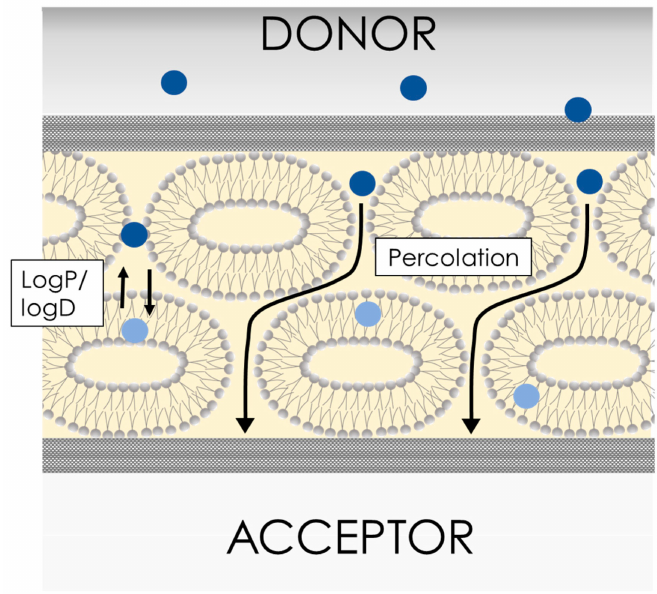
Figure 10. Schematic representation of a hydrated PermeaPad. This barrier is constituted by a liposomal gel contained within two low-retention inert layers. The drug molecules can diffuse through the liposome bilayers, i.e., exploiting partitioning, and/or they can diffuse directly through the para-liposomal